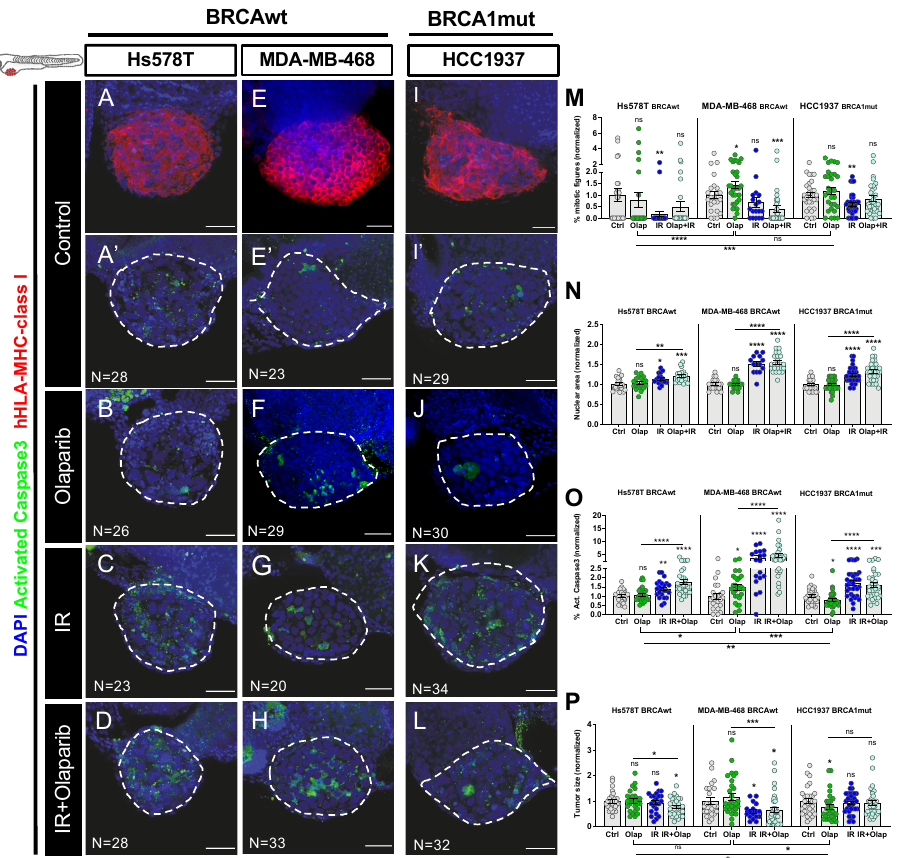
Figure 3. Zebrafish xenografts of triple negative breast cancer (TNBC) reveal di ff erent responses to olaparib and ionizing radiation (IR) independently of BRCA status. TNBC cell lines (Hs578T BRCAwt , MDA-MB-469 BRCAwt and Hcc1937 BRCA1mut ) were fluorescently labeled with CM-DiI (not shown) and injected into the perivitelline space (PVS) of 2dpf zebrafish embryos. At 24 hpi, zebrafish xenografts were screened and randomly distributed into the di ff erent experimental conditions: control, olaparib, IR, IR + olaparib. Xenografts were treated for 4 consecutive days and fixed at 5dpi. Representative confocal images of xenografts labelled with anti-human-leukocyte antigen-major histocompatibility complex (HLA-MHC)-class I (in red) ( A,E,I ) and anti-activated caspase 3 (in green) ( A’ – L ). Nuclei were stained with DAPI (in blue) ( A – L ). Mitotic index ( M) , nuclear area size ( N ), cell death-activated caspase3 ( O ) and average tumor size (number of human DAPI cells) ( P ) were analyzed by confocal microscopy and quantified. The % of activated caspase 3 cells and tumor size were normalized to respective controls to compare between di ff erent xenografts in di ff erent conditions. All images are anterior to the left, posterior to right, dorsal up, and ventral down (as depicted in the scheme on top left). The dashed line delineates the tumor area. Scale bar: 50 µ m. Results are from three independent experiments and expressed as mean ± SEM, each dot represents one xenograft. The total number of xenografts analyzed is indicated in the images. Statistical results: ns > 0.05, * p ≤ 0.05, ** p ≤ 0.01, *** p ≤ 0.001, **** p ≤